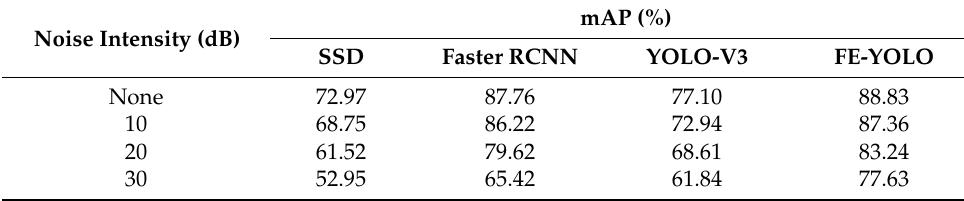
Table 15. The accuracy under white Gaussian noise of different intensities. Noise Intensity (dB)